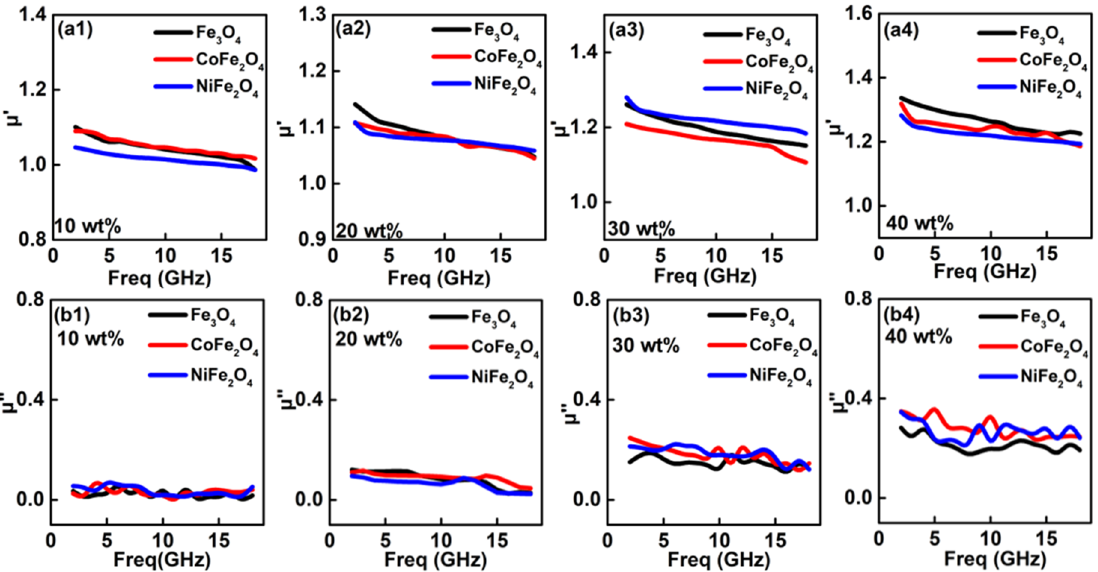
Figure 6. Frequency dependency of permittivity values for the absorption layer with various con- tains of ferrites: ( a1 ) μ ′-10 wt%; ( a2 ) μ ′-20 wt%;( a3 ) μ ′-30 wt%;( a4 ) μ ′-40 wt%; ( b1 ) μ ″-10 wt%;( b2 ) μ ″-10 wt%;( b3 ) μ ″-30 wt%;( b4 ) μ ″-40 wt%.